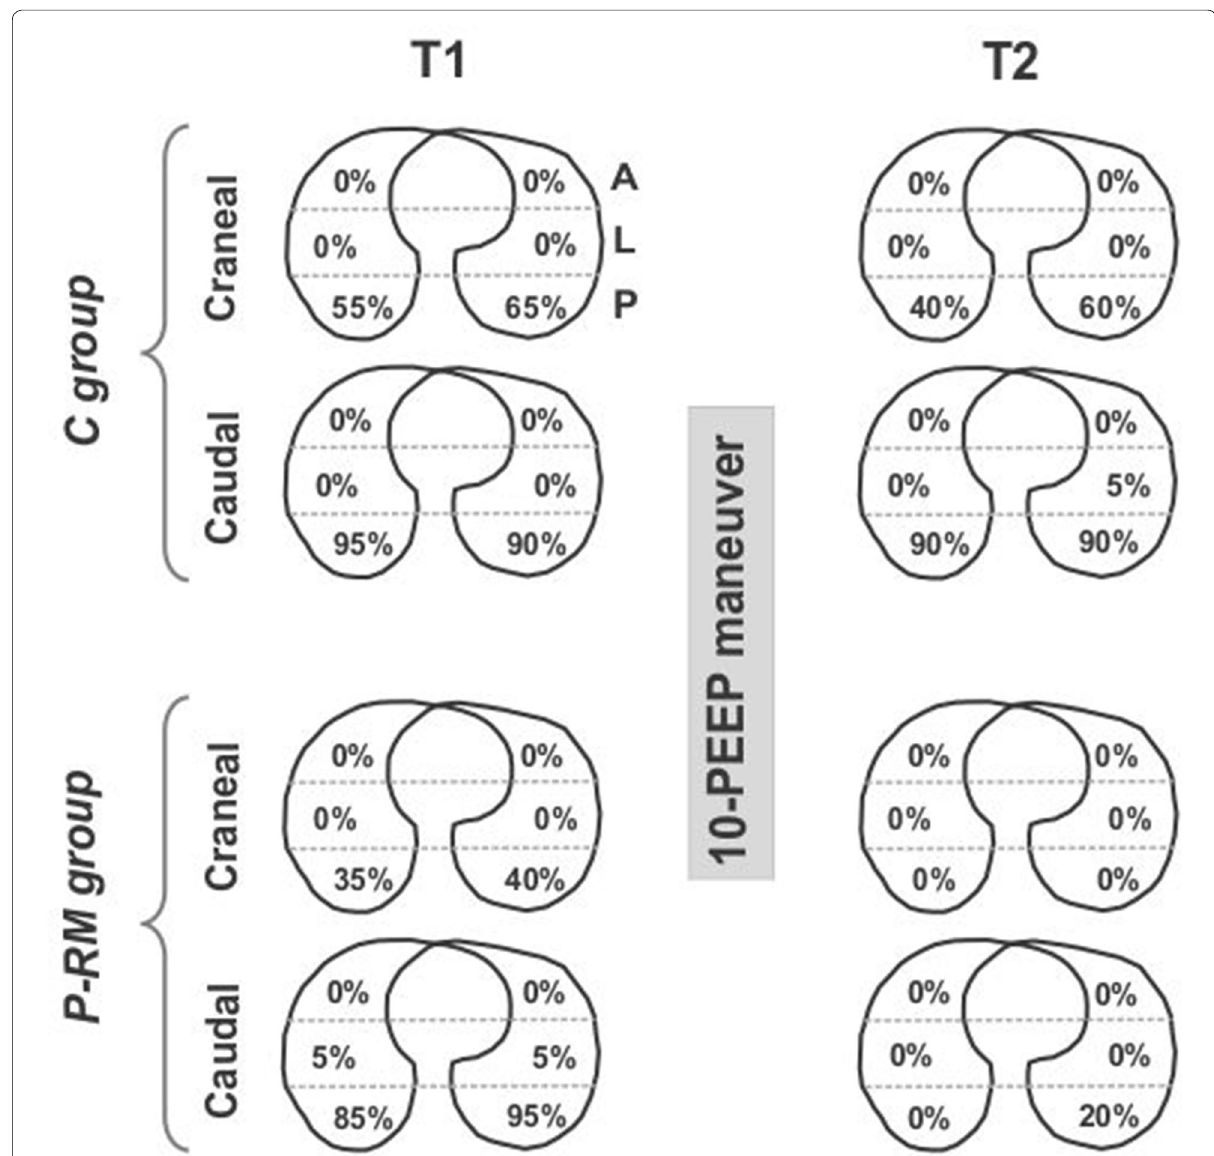
Fig. 5 Distribution of atelectasis between groups along the study. C group control patients, P-RM postural recruitment patients, A anterior, L lateral, P posterior lung zones assessed by lung ultrasound. Cranial axial cut representing the superior thoracic area above a horizontal line crossing the = nipples. Caudal axial cut representing the inferior thoracic area below a horizontal line crossing the nipples. % = group that presented atelectasis in a particular lung